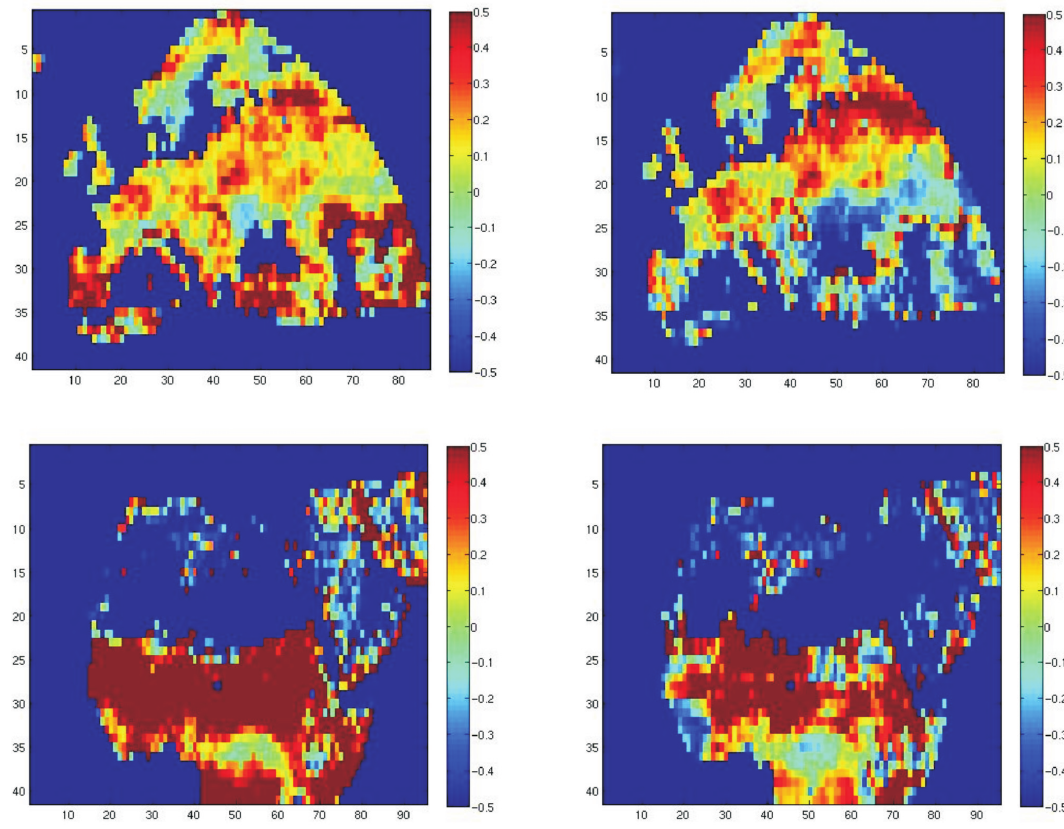
Fig. 7. 1 ◦ × 1 ◦ maps of bias between ECMWF ET and LSA SAF MET (left) and between GLDAS and LSA SAF MET (right) over the whole period of inter-comparison. Europe (upper part), North of Africa (lower